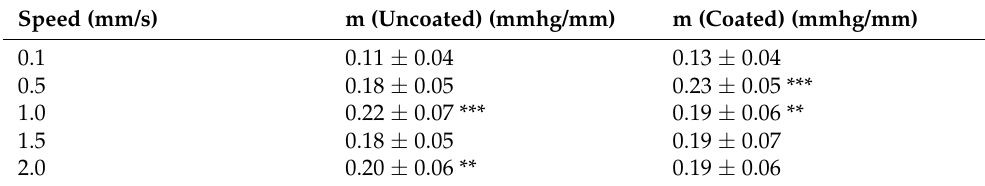
Figure 3. Cochlear electrode array insertion pressure measured with the linear cochlea model. Measurements were performed over a 30-mm insertion depth at 5 different insertion speeds (0.1, 0.5, 1.0, 1.5, and 2.0 mm/s). ( a , d ) Curve diagrams of insertion pressure of uncoated ( a ) and coated ( d ) electrode arrays. ( b , e ) Maximum insertion pressure of uncoated ( b ) and coated ( e ) electrode arrays. ( c , f ) Insertion pressure during insertion (area under the curve (AUC)) of uncoated ( c ) and coated ( f ) electrode arrays. n = 10 independent repetitions were performed for each insertion speed. Data are presented as mean with positive standard deviation (lines). Dots represent independent measured values. p -values were calculated by one-way ANOVA followed by Bonferroni’s multiple comparison post hoc test. ** p < 0.01. *** p < 0.001. **** p < 0.0001. n. s. = not significant. Data were compared to data at 0.1 mm/s. Table 1. Slope (m) of insertion pressure of uncoated and coated electrode arrays at different insertion speeds (0.1, 0.5, 1.0, 1.5, and 2.0 mm/s). p -values were calculated by two-way ANOVA followed by Sidak’s multiple comparison post hoc test. ** p < 0.01. *** p < 0.001. Data were compared to data at 0.1 mm/s of the respective column.